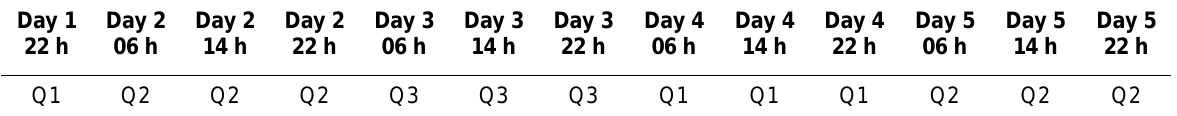
Application Scheme of Test and Control Dilutions (for explanation, see